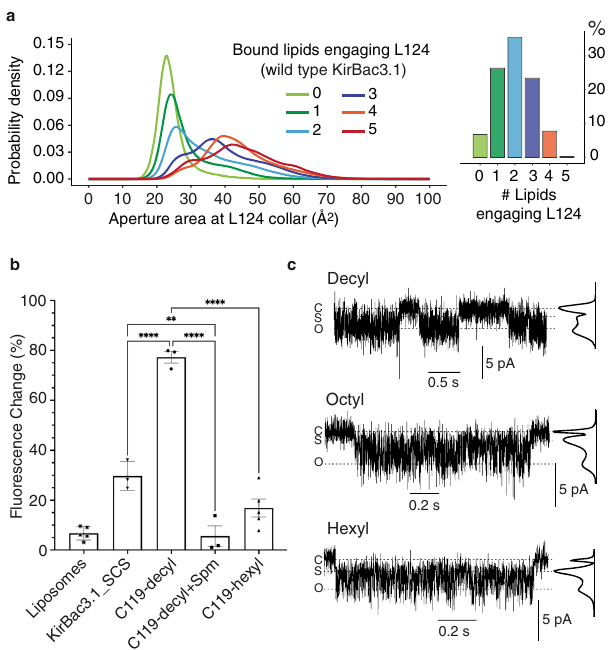
Fig. 3 Alkyl chain length and relative occupancy determine collar opening and channel activity. a The number of lipids engaging with Leu124 side chains varies as a normal distribution. Its relationship to the cross-sectional area of the open collar between leucine side chains is depicted. b Summary ACMA assay data for the C119-decyl ( n = 3 independent samples) and C119-hexyl derivatives ( n = 5 independent samples) represented as mean ± SEM. Values of n in control samples are 5, 3, and 3 for liposomes only, KirBac3.1-SCS, and C119-hexyl + spermine. Data analysis was by two- sided t -test analysis of variance and refers to pairwise comparisons to KirBac3.1 or KirBac3.1-SCS as indicated (ns = non-signi fi cant; * p ≤ 0.05; ** p ≤ 0.01; *** p ≤ 0.001; **** p ≤ 0.0001). Comparative p -values for comparison of C119-decyl to C119-hexyl, C119-decyl + spermine, and KirBac3.1-SCS are all <0.0001. The p -value for comparison of KirBac3.1-SCS to C119-decyl + spermine is 0.0037. The 95% con fi dence intervals, in respective order, are (46.1 – 74.6), (55.8 – 87.5), (31.6 – 63.4), and (8.9 – 39.4). Dunnett ’ s test was applied to adjust for multiple comparisons to each control. Source data are provided as a Source data fi le. c Single channel recordings of C119-decyl, C119-octyl and C119-hexyl at − 80 mV, fi ltered at 500 Hz. Open (O), closed (C) and partially open substate (S) levels determined by Hidden Markov Models are indicated by horizonal dashed lines. Maximum-likelihood amplitude histograms generated using Hidden Markov Models are aligned with the